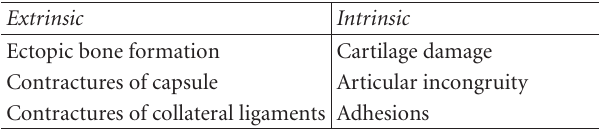
Figure 3: A high-magnification histology slide of the cavernous- type tumour showing dilated vascular channels with little muscular thickening of the walls. Table 1: Causes of elbow